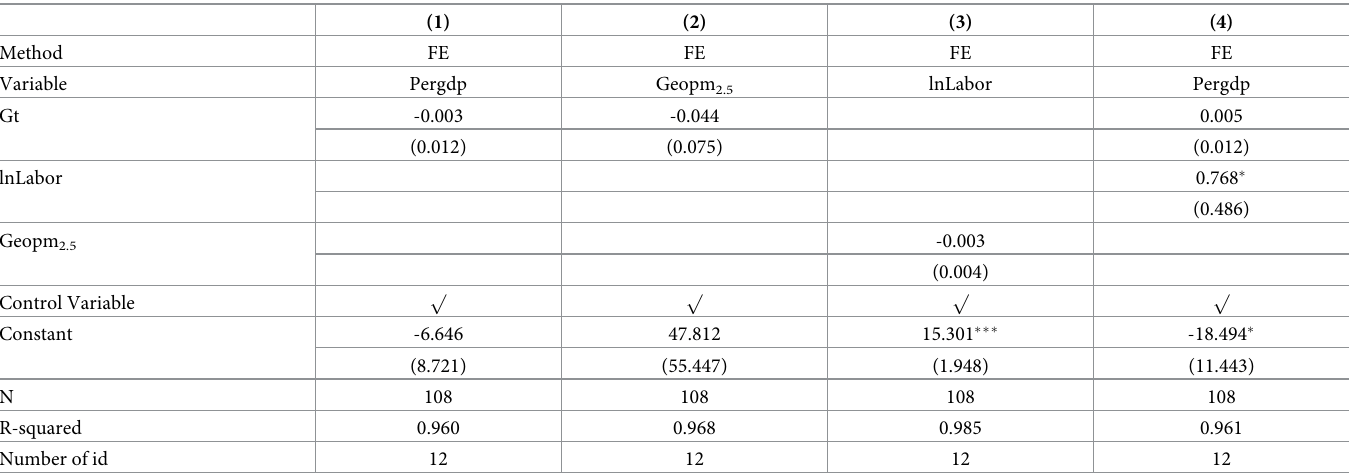
Table 3. Estimation of the mediating effect of labor supply at the regional level in eastern China.